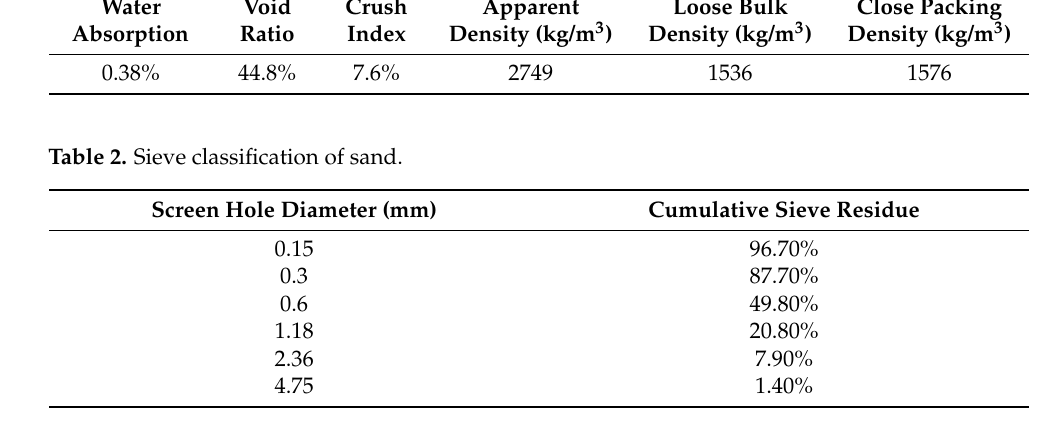
Table 1. Physical properties of coarse aggregate. Water